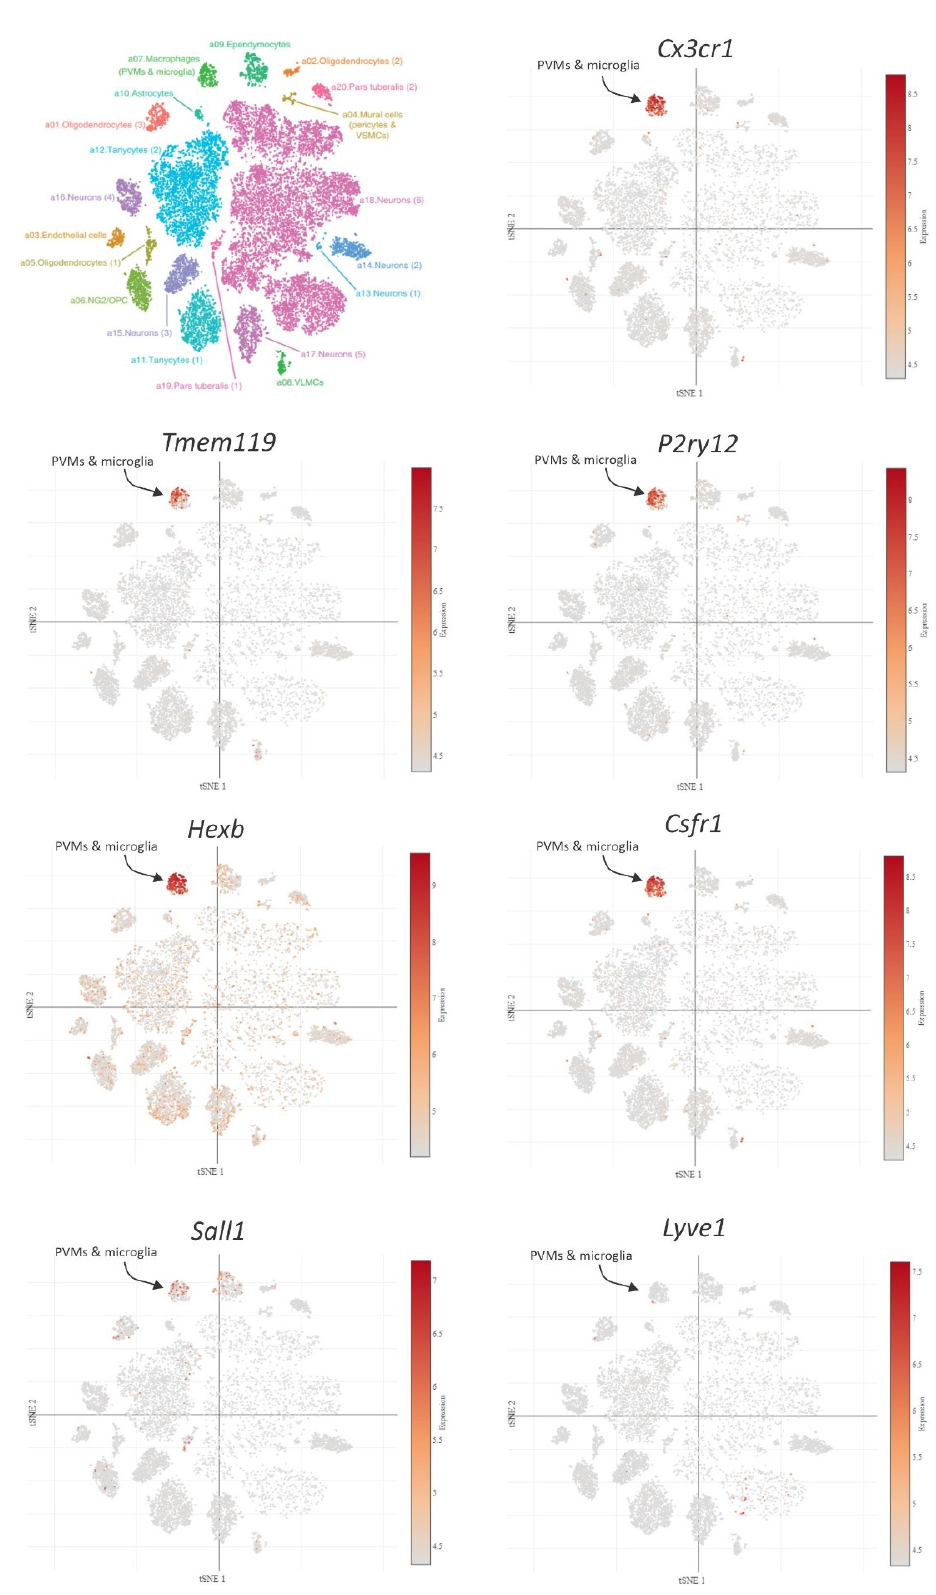
Figure 4. Distribution of genes in the arcuate nucleus (ARC) and median eminence (ME) chosen to generate mouse models that target microglia and perivascular macrophages (PVMs). Scatter plot images were obtained from https://singlecell.broadinstitute.org/ accessed on 20 November 2020, ARC-ME DROPSEQ data is from Campbell et al.